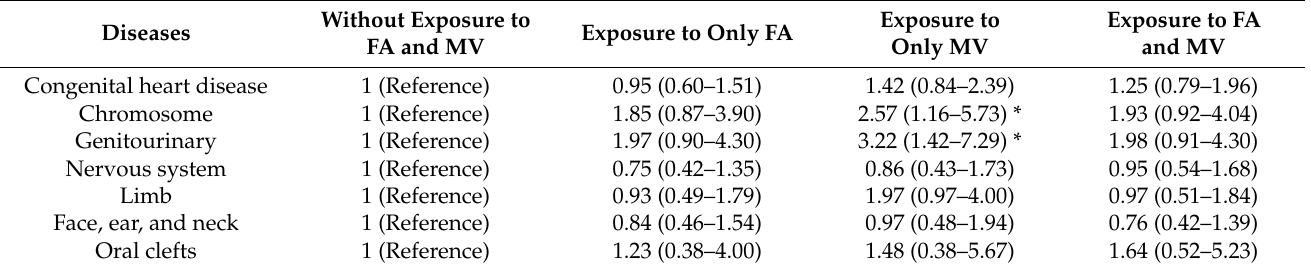
Table 4. The adjusted RR and its 95% confidence interval of major birth defects in different expo- sure